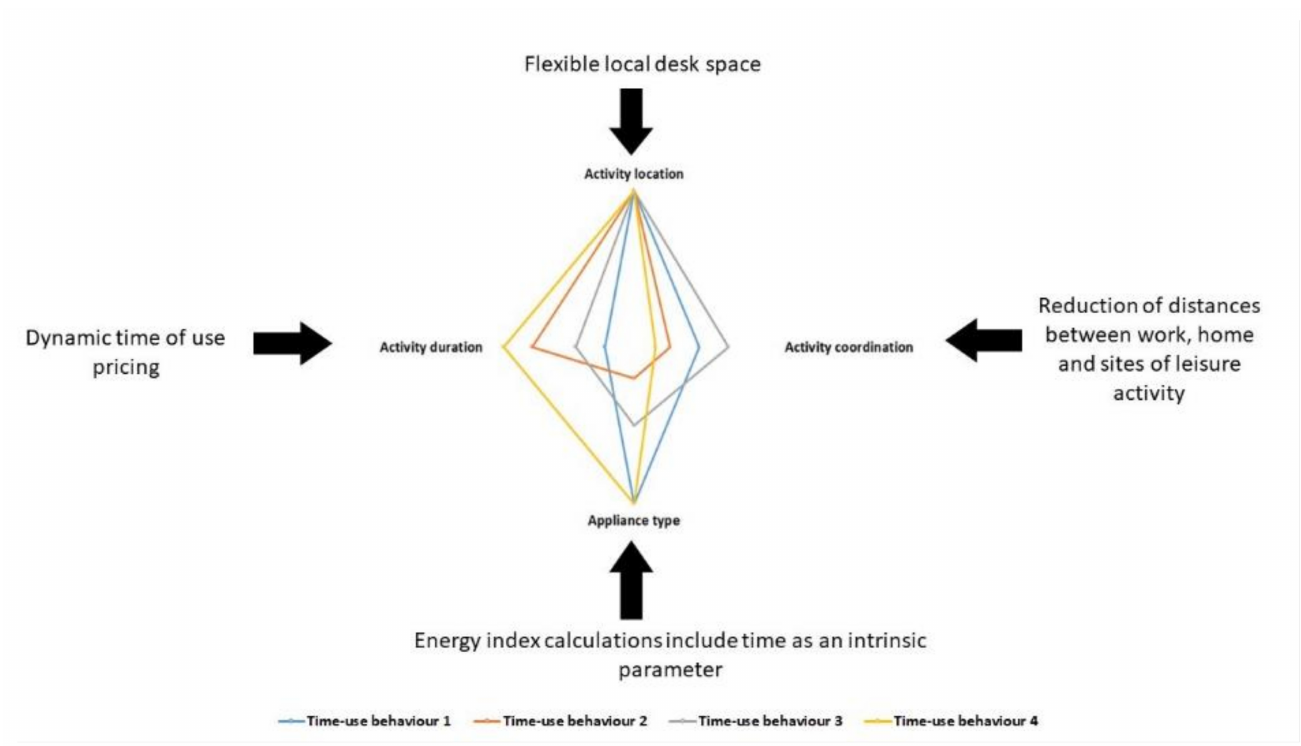
Figure 8. Examples of time-use policy measures aimed at decreasing residential energy